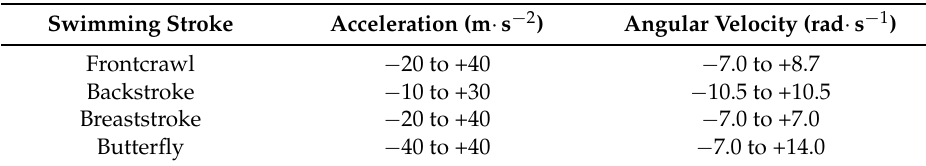
´ 40 to +40 ´ 7.0 to